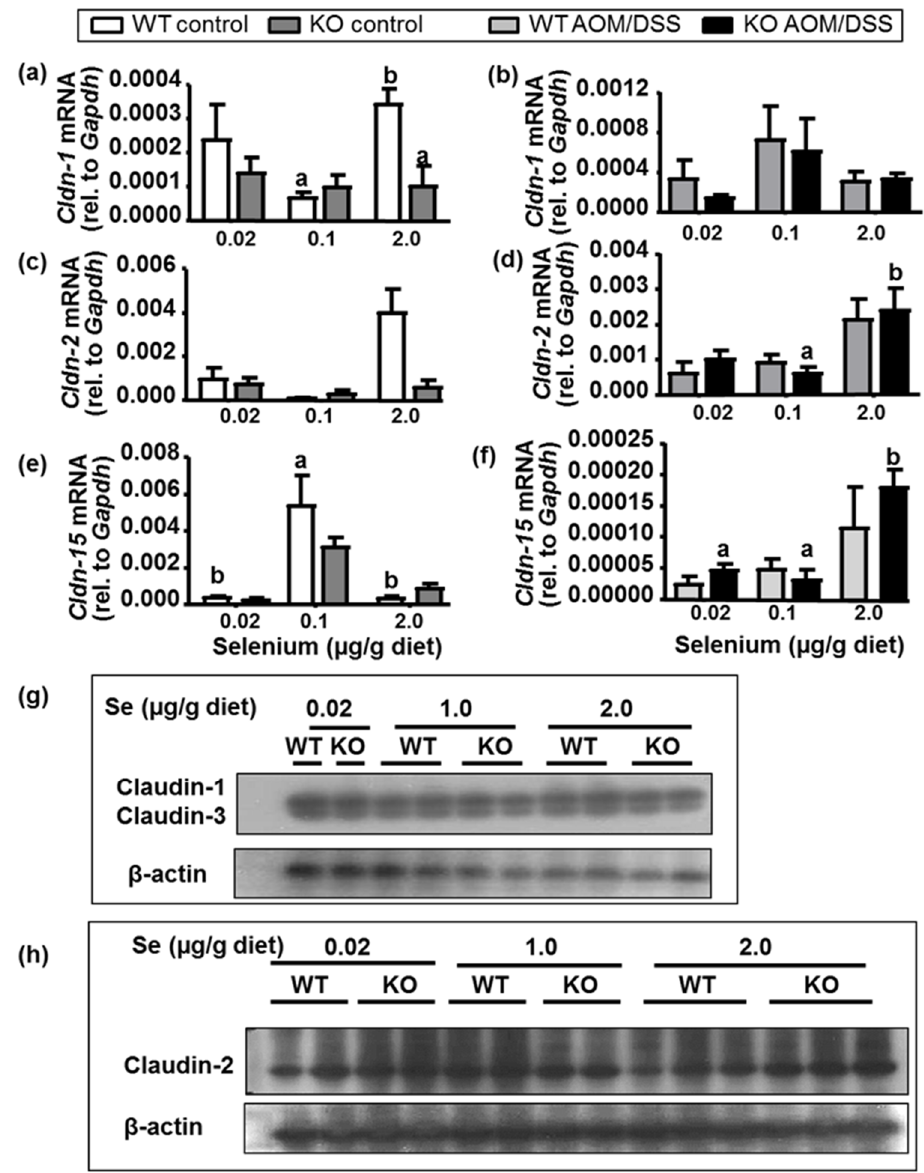
Figure 5. Expression of tight junction Claudin genes. mRNA expression was measured with qPCR in ( a , c , e ) colon scrapes of control mice and ( b , d , f ) colon tumors of AOM/DSS-treated mice. Mean (N = 4) + SEM, 2-way ANOVA, followed by Tukey’s post hoc analyses to compare KO vs. WT by diet; letters indicate statistically significant differences. Protein expression of ( g ) Claudin-1 and Claudin-3, and ( h ) Claudin-2 in colon scrapes of control mice on selenium-specific diets was assessed with Western blotting, using β -actin as loading control. N = 1–3 per group, 40 µg protein per lane.